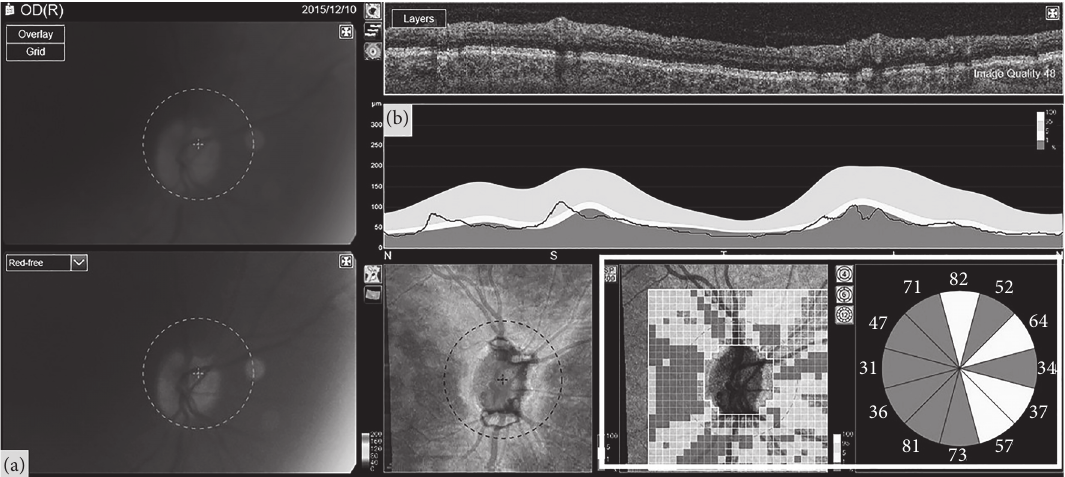
Figure 1: Optic nerve head (a) and retinal nerve fiber layer analysis (b) as obtained with swept-source optical coherence tomography in a 43-year-old patient with multiple sclerosis who suffered a previous episode of optic neuritis 5 years ago. The pixel map and the clock sector analysis (marked with the white square) of the optic disc shows important retinal nerve fiber layer loss in most sectors of the peripapillary area.